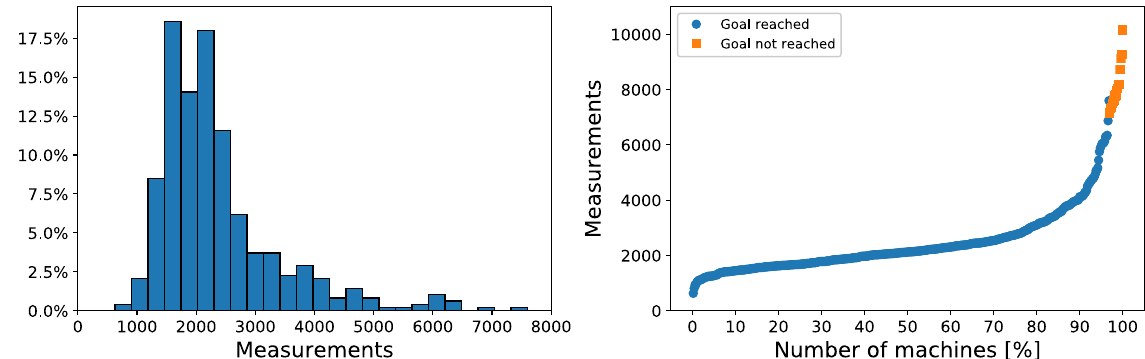
FIG. 8. Left: Histogram of the total number of measurements needed to reach the target luminosity. The median of the number of measurements is 2104. Right: Cumulative distribution of number of measurements needed to reach the luminosity target. 90% of machines reached the target in 4100 measurements or less.